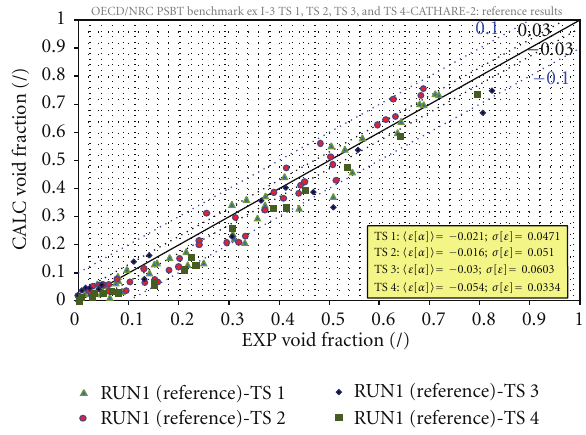
Figure 2: Overall subchannels tests (126 tests)—CATHARE2 v2.5 1 code, reference